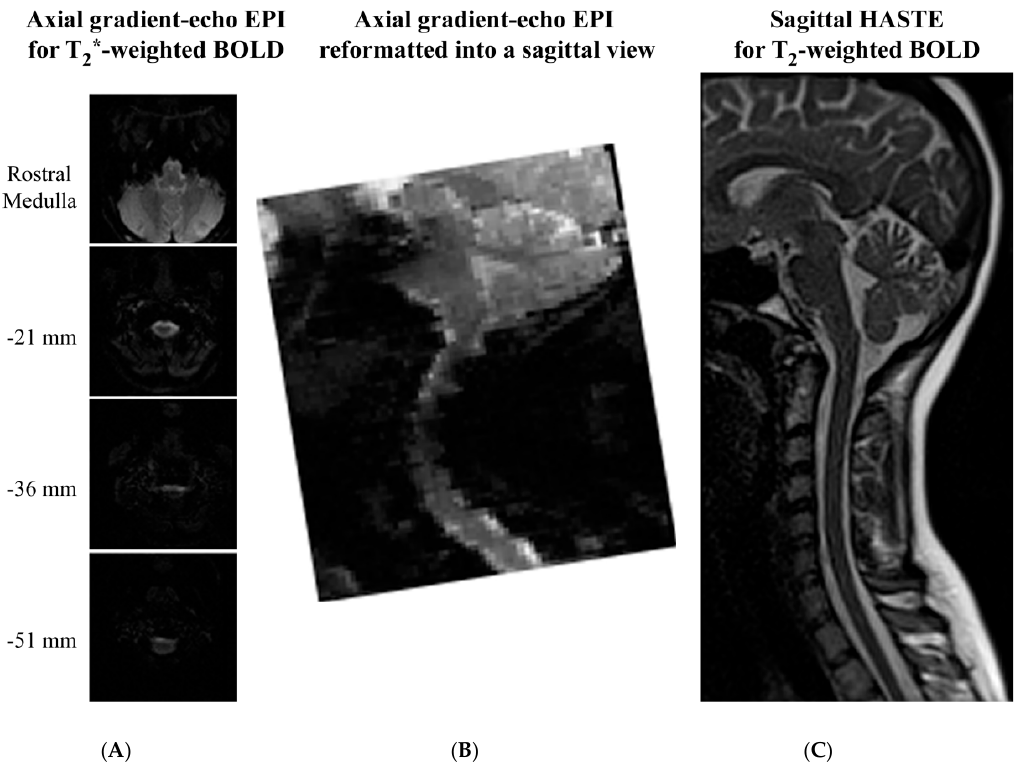
Figure 4. Comparison of image quality obtained with gradient-echo EPI and spin-echo HASTE sequences for spinal fMRI. Gradient-echo EPI images were acquired in contiguous axial slices ( A ) and were reformatted into sagittal views ( B ) for comparison with spin-echo (HASTE) images acquired in sagittal planes ( C ). Selected axial slices are shown for comparison, and the slice positions are indicated relative to the caudal medulla (top slice). Images were acquired at 3 tesla with a Siemens MAGNETOM Trio at Queen’s University, and used as examples for this review.